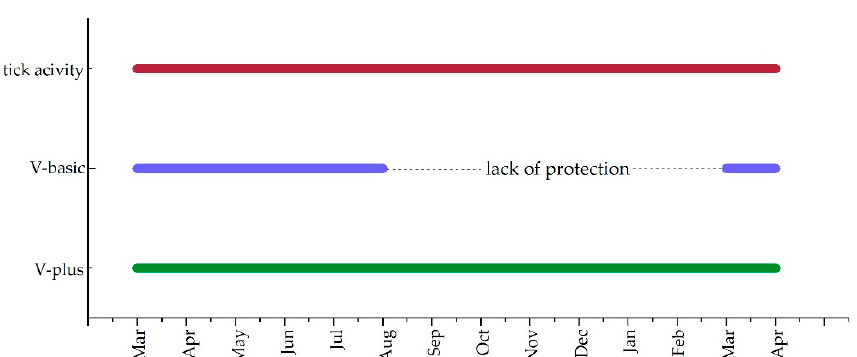
Figure 3. Tick activity and LB protection in different vaccination groups using two vaccination schemes compared over one year when LB vaccination is initiated in spring.